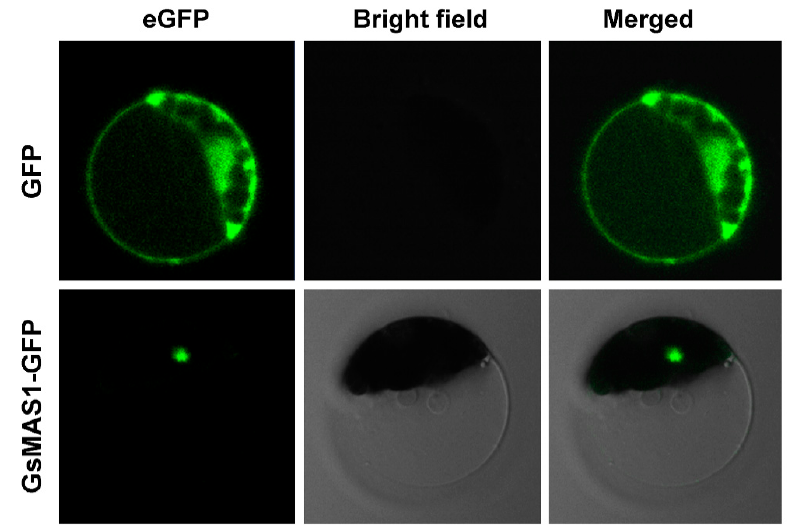
Figure 3. Subcellular localization of GsMAS1 protein.